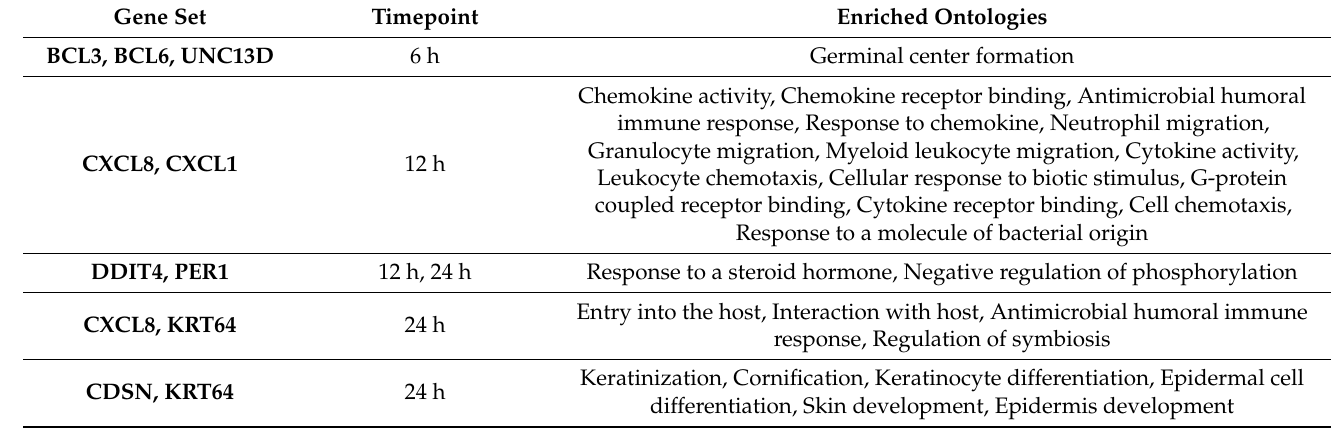
Table 1. Gene ontology terms significantly enriched for the 47 differentially regulated genes identified by this study. Gene Set Timepoint Enriched Ontologies BCL3, BCL6, UNC13D 6 h Germinal center